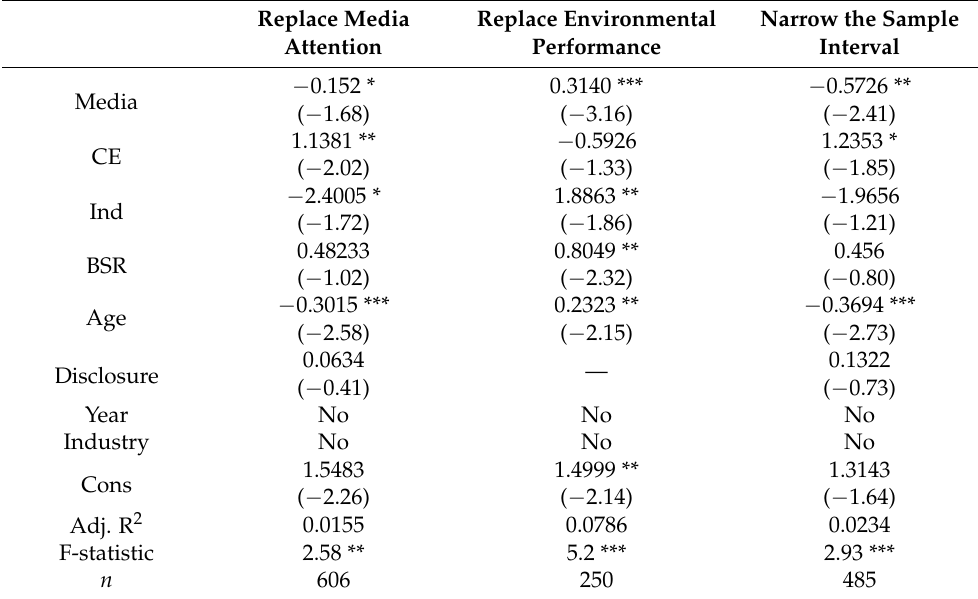
Table 9. Robustness test